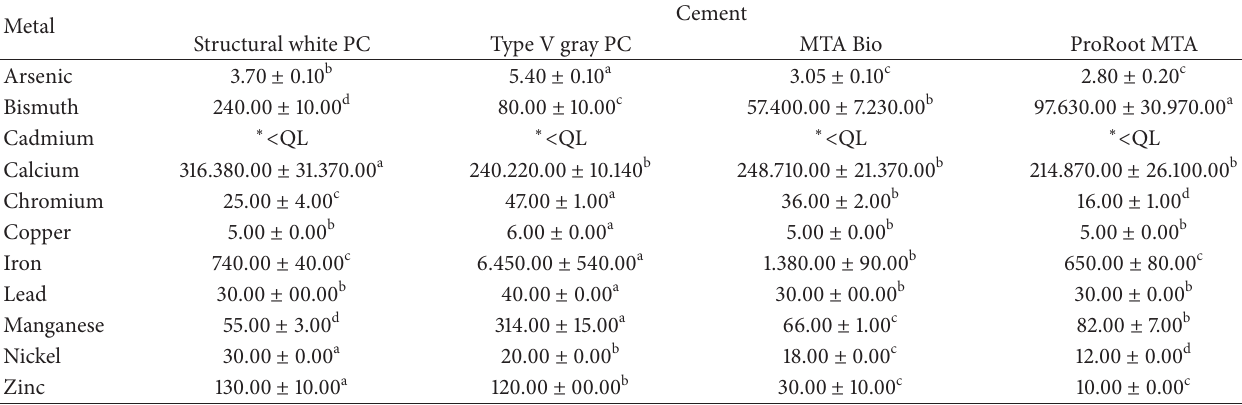
Table 4: Means and standard deviations of metal contents (mg/kg) for the tested materials by using atomic absorption spectrophotometry.